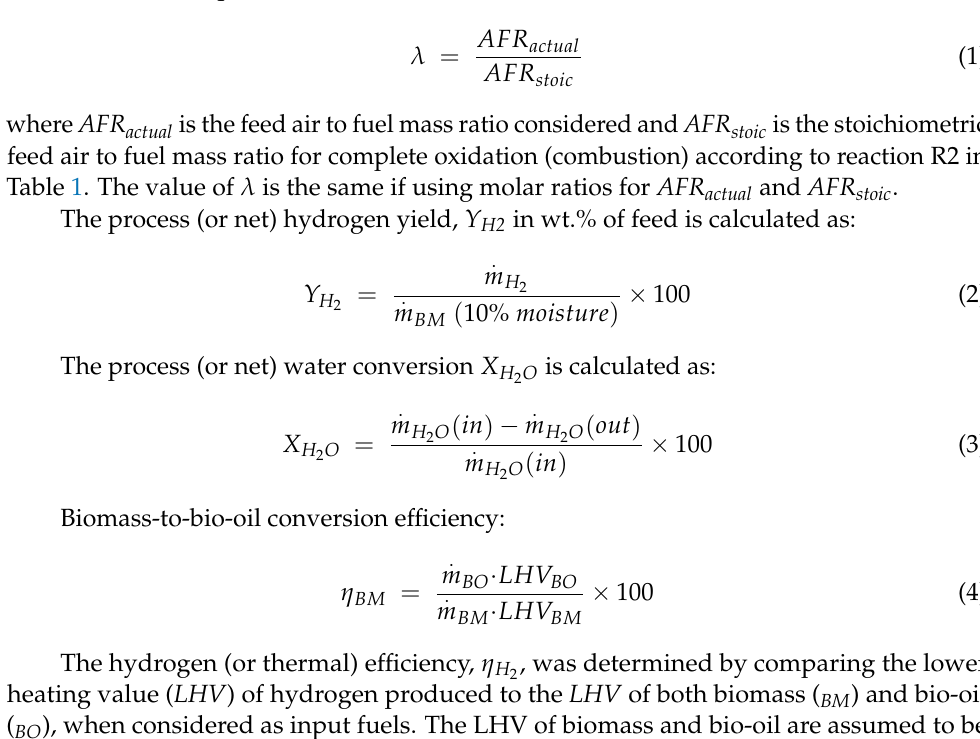
Table 4. Pyrolysis yield at 500 ◦ C and 1 bar for 10% moisture PEFB (3333.3 kg/h). Phase Yield (wt.%) Phase Yield (wt.%) Solid (char and ash) 15 Liquid (bio-oil) 70 Gas 12 Ash 3 Bio-Oil Compound Mass Fraction Bio-Oil Compound Mass Fraction Acetic acid 0.055 Levoglucosan 0.027 Formaldehyde 0.060 Palmitic acid 0.005 Acetaldehyde 0.005 H 2 0.006 2-butanol 0.005 CH 4 0.003 Furfural 0.098 CO 0.063 Phenol 0.005 CO 2 0.052 Creosol 0.022 C (char) 0.123 Guaiacol 0.087 Ash 0.031 Catechol 0.180 H 2 O